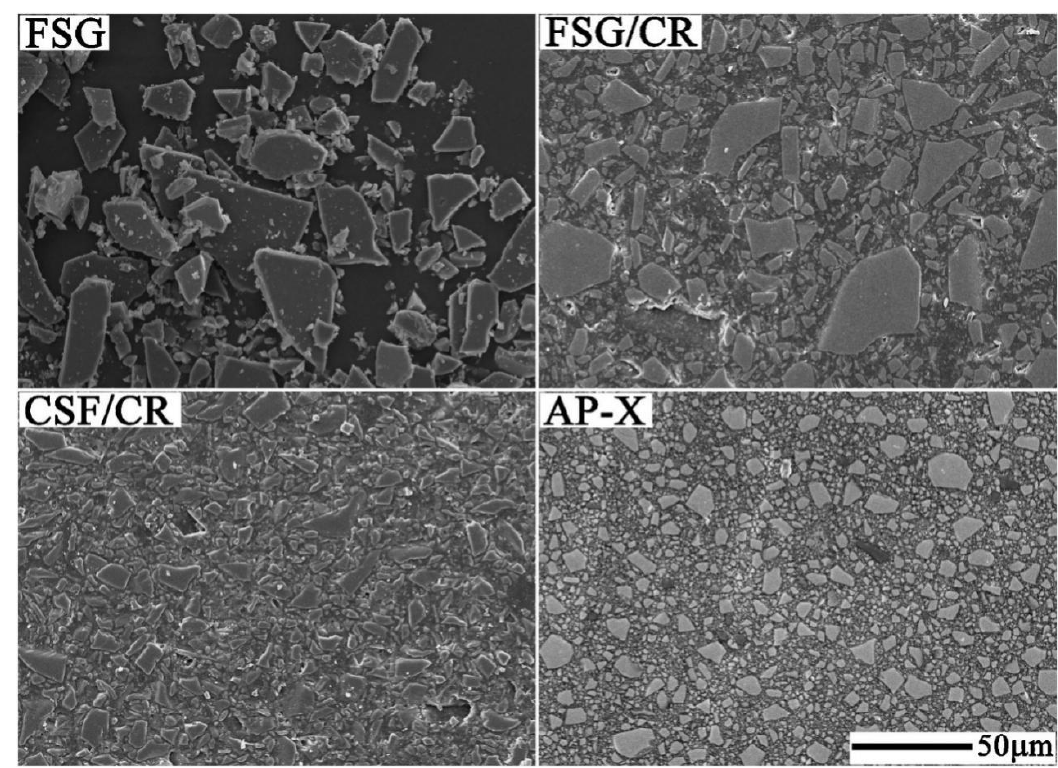
Figure 14. SEM images of flake-shaped glass (FSG), FSG/composite resin (CR) (60 wt%), crushed silica filler (CSF)/CR (60 wt%), and a commercial CR clearfil-AP-X. The FSG is platelet-shaped with a flat surface and is smaller than 50 μm. The particle size of FSG is larger than that of the CSF and the filler contained in AP-X. Images from [100].